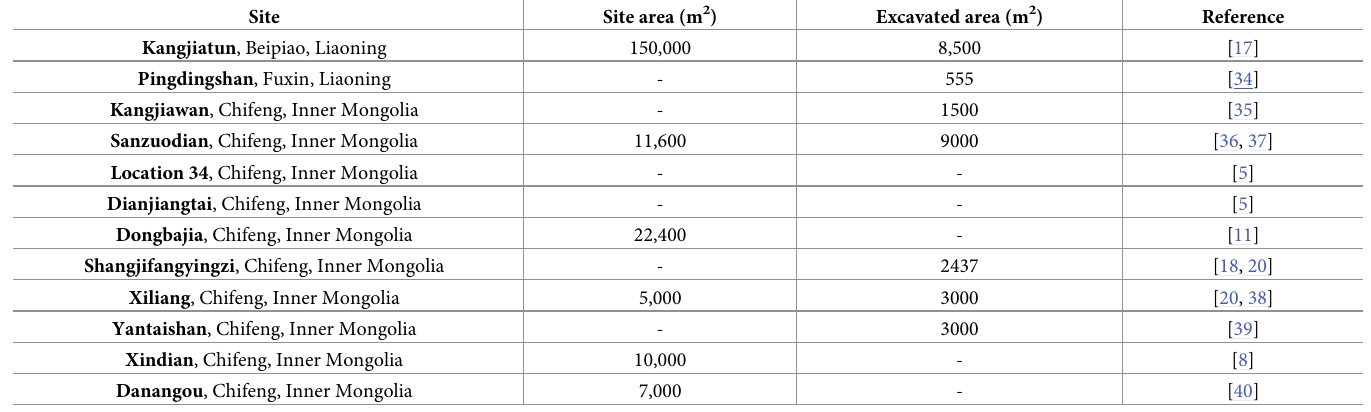
Table 2. Type B: High hillfort stone